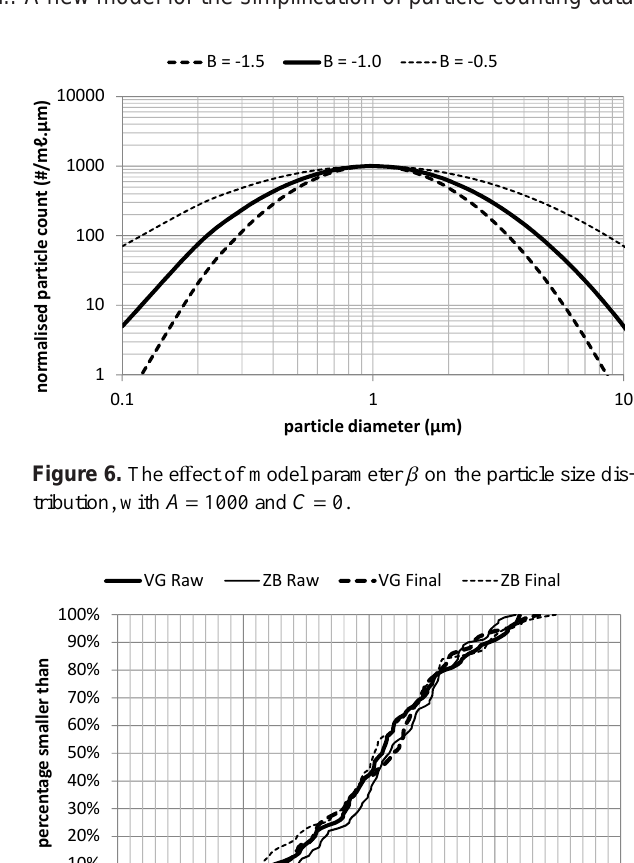
Fig. 7 is that the cumulative distributions for the raw and treated waters are not di ff erent. Using the 10th and 90th per- centiles as guidelines, the range of β was from − 1.4 to − 0.5.